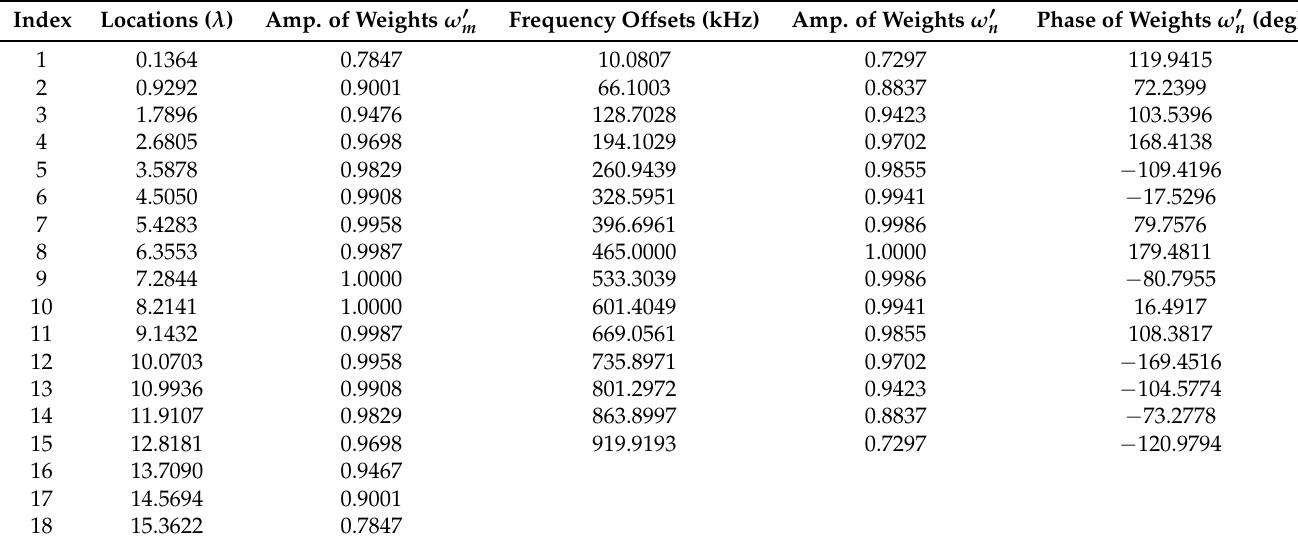
Table 4. The positions, excitations, and frequency offsets of the obtained sparse